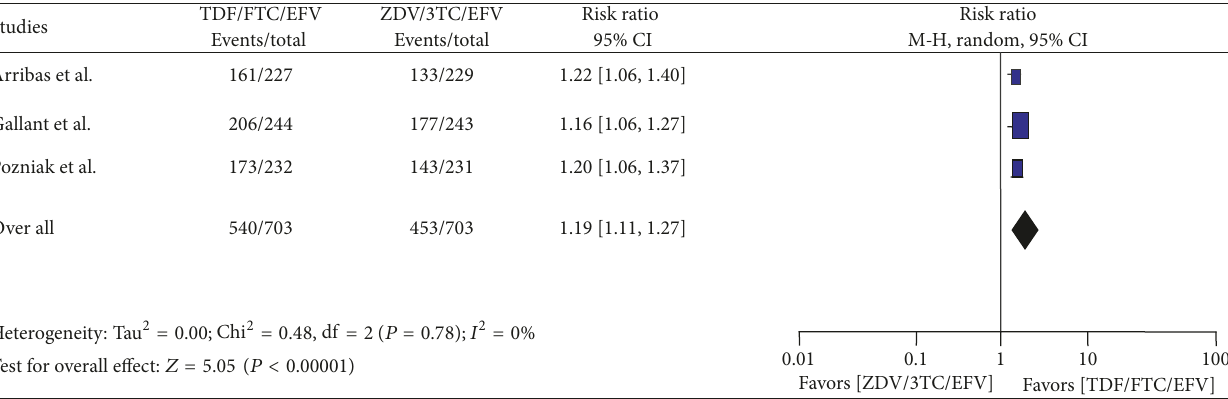
Figure 2: Forest plot of viral load suppression to less than 400 HIV RNA copies/ml in the TDF arm as compared to ZDV arm in ART na¨ıve HIV-1 infected patients.